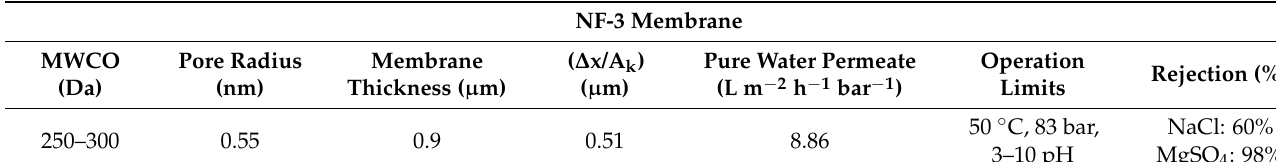
Table 1. Characteristics of nanofiltration membrane [56].